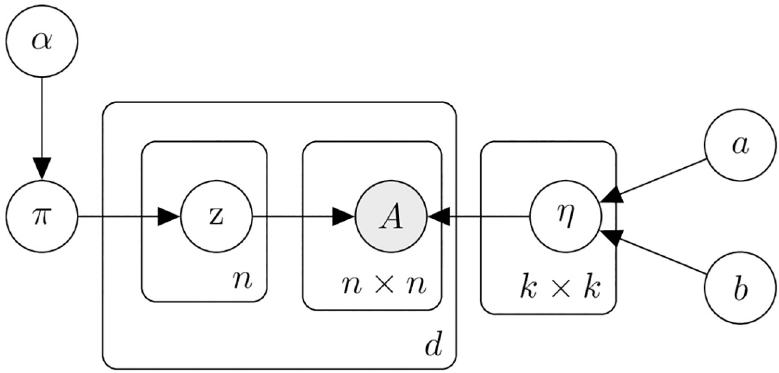
Fig 1. Plate diagram for the SBM on multiple networks for the same experimental condition. Each node u has a device-specific community assignment z ð d Þ